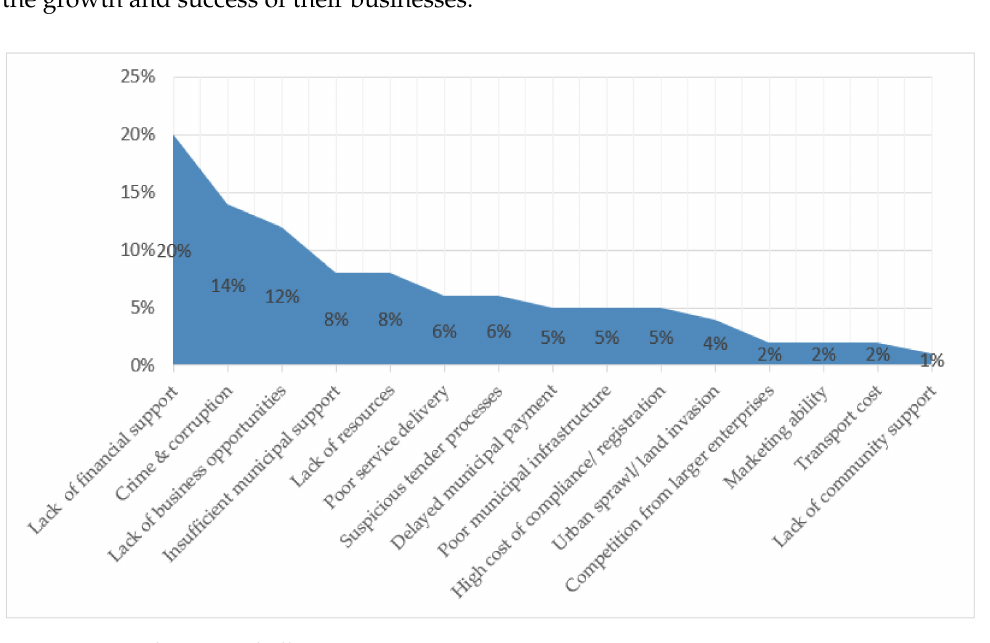
Figure 4. Main business challenges.